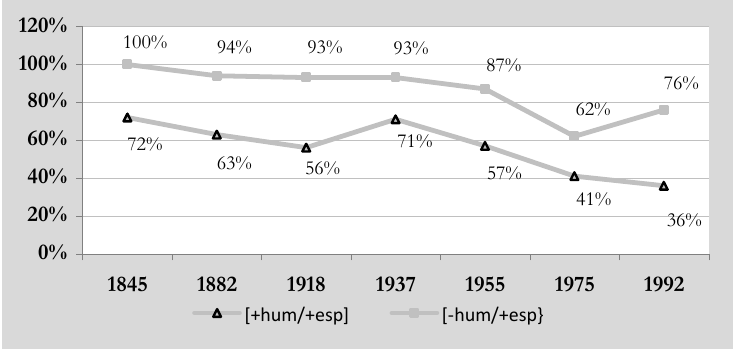
Fig. 2. Null ( vs. overt) third person subjects and the combination of semantic features of the referent (Adapted from Duarte, Mourão and Mendonça, 2010: